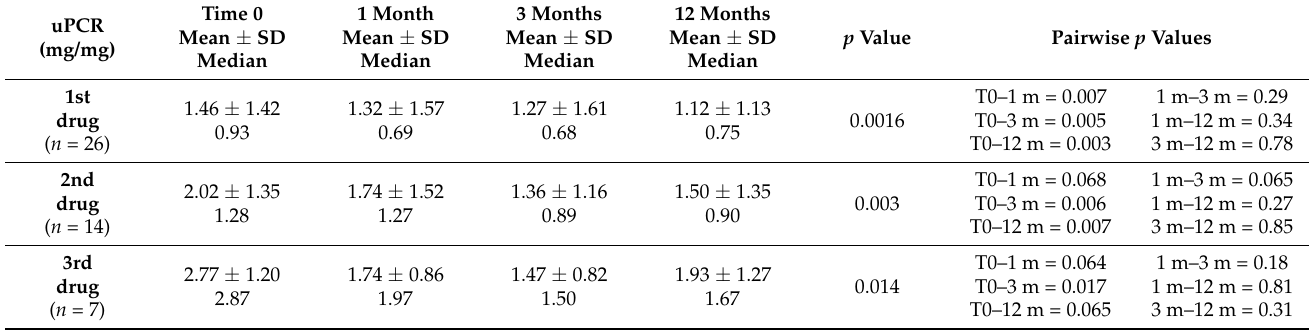
Table 2. Distribution of uPCR values at different time points from the introduction of the first, second, and third RAAS blocker. Most data were significantly right-skewed. All p values are from Repeated Measures Anova analysis of log- transformed